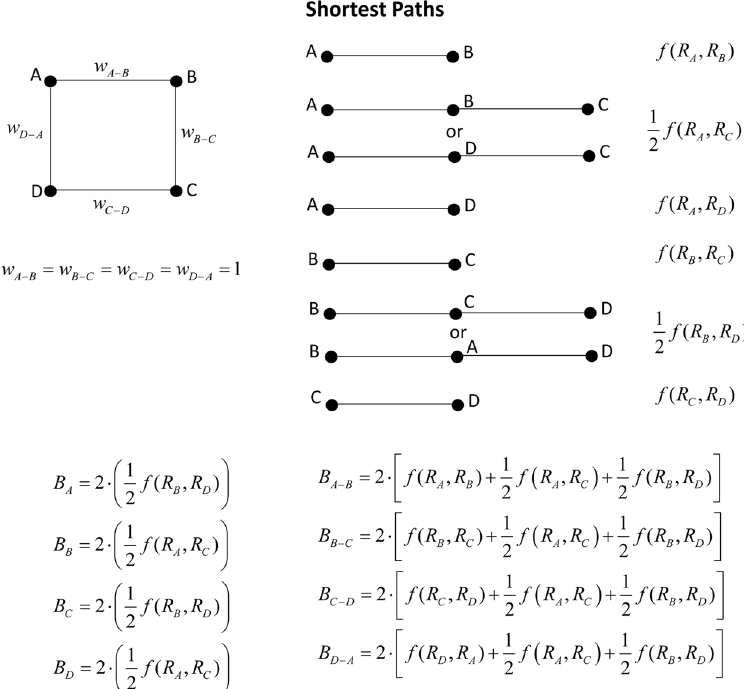
Figure 4. Regular network: betweenness case using an unweighted network.